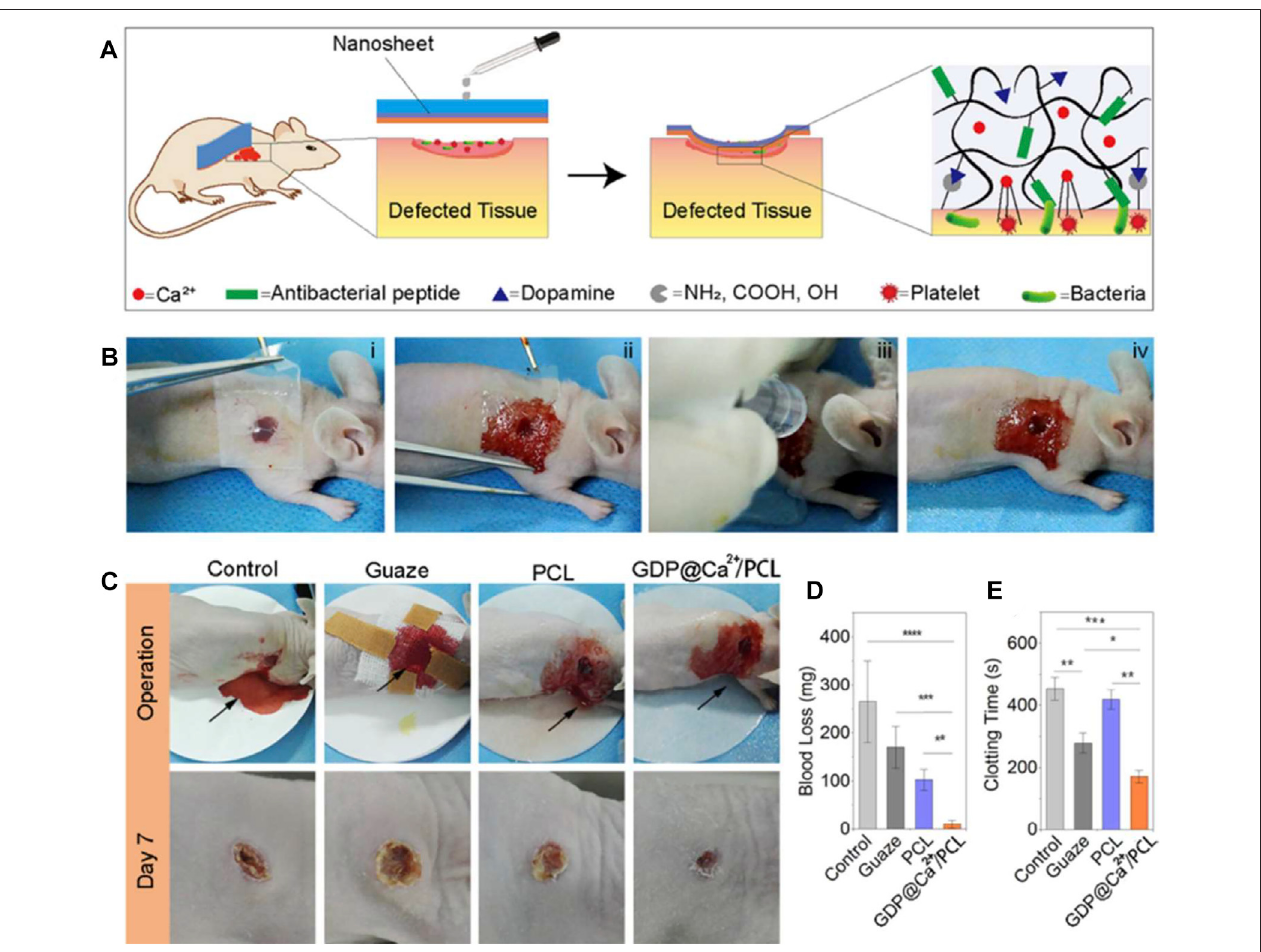
FIGURE 6 | The hemostatic and sealing performances of nanosheets on the dorsal skin of a nude mice model. (A) Schematic of using a nanosheet to heal skin wounds with bleeding and infection. (B) The operation process of a GDP@Ca 2+ /PCL nanosheet on a wound. (C) Images of wound healing after treatment with gauze, PCL and the GDP@Ca 2+ /PCL nanosheets, with an untreated wound serving as the control group. (D,E) The blood loss (D) and clotting time (E) evaluations of the samples. Reproduced from (Xuan et al., 2020) with permission from Copyright 2020 Elsevier.